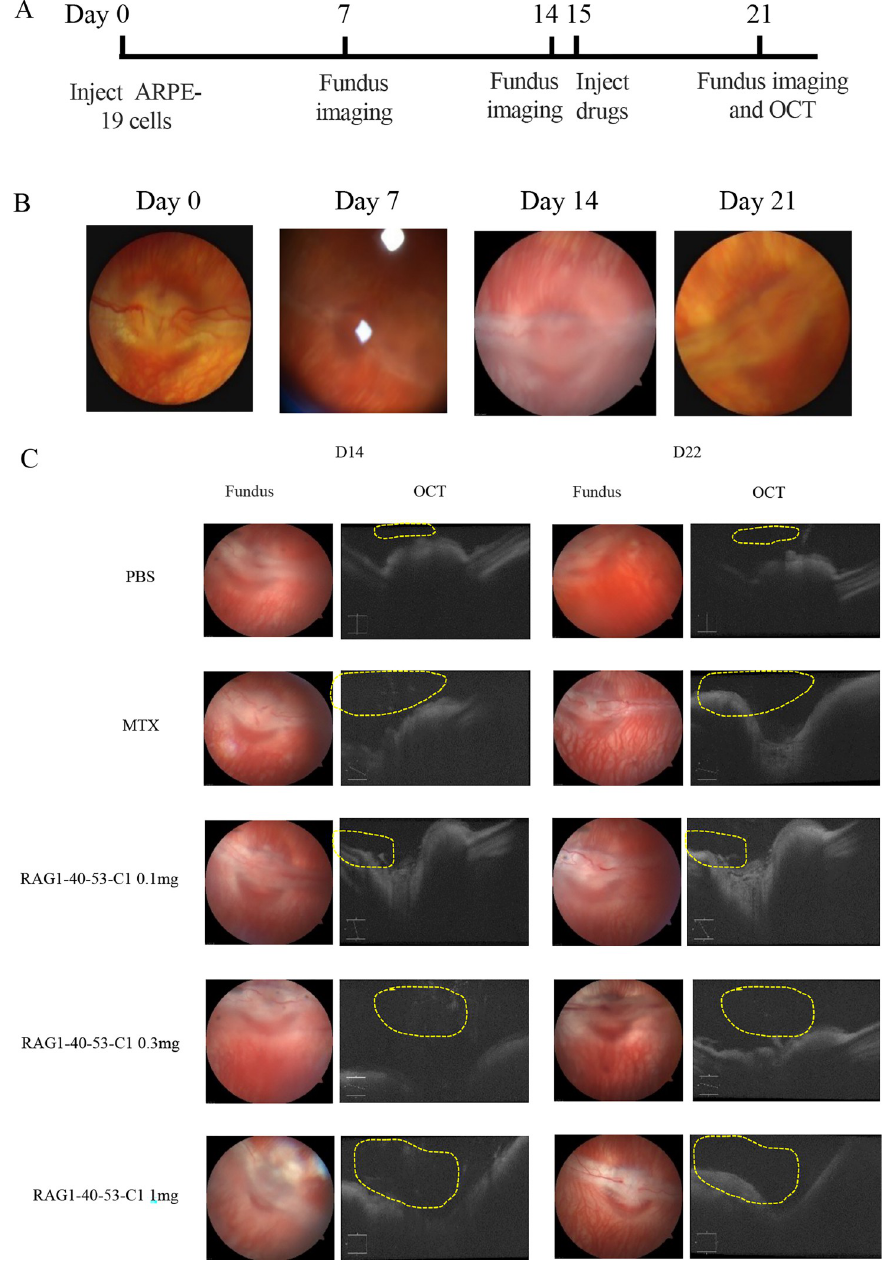
Fig 6. RAG1-40-53-C1(saRNA) inhibit the fibrosis of ARPE-19 cells and reduce the grade of PVR in vivo. (A) The PVR in vivo model was constructed in the eyes of rabbits, and the changes over time were observed by fundus photography. (B) Drug efficacy trial schedule. (C) Drug effect test. RAG1-40-53-C1 injection induced an increase in P21 mRNA expression in rabbit eyes. The yellow circles indicate fibrous new membrane like material. PBS group, MTX group, saRNA transfection group (RAG1-40-53-C1 0.1mg, RAG1-40-53-C1 0.3mg, RAG1-40-53-C1 1.0mg). The changes of PVR were observed by fundus photography and OCT on day 14 and 22. ( � P < 0.05, �� P < 0.01).